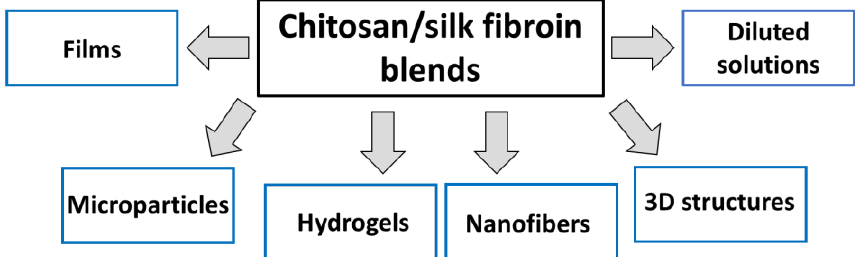
Figure 5. The most typical forms of chitosan/silk fibroin mixtures.